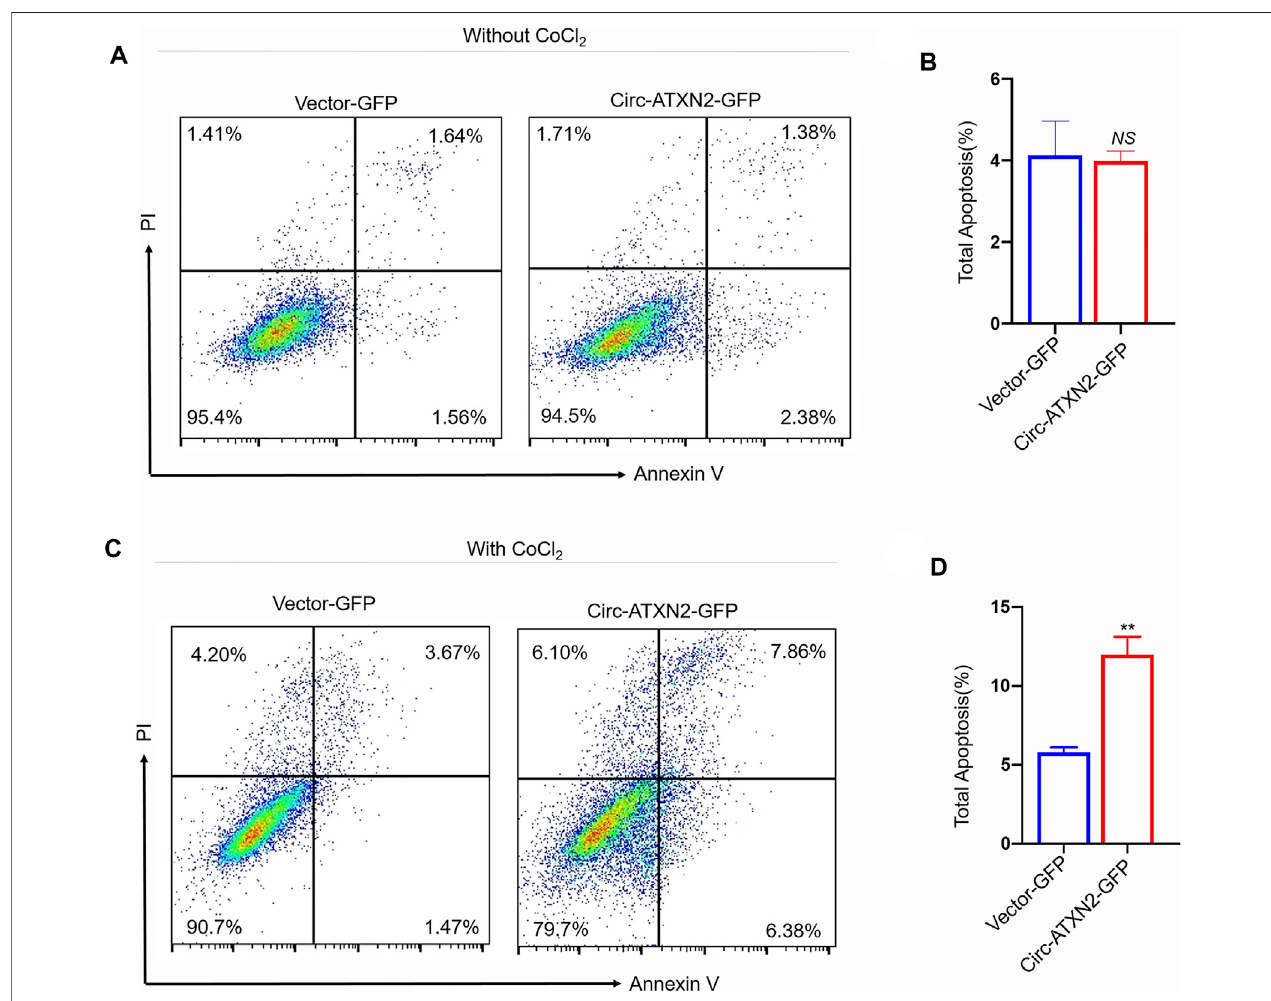
FIGURE 6 | Overexpression of circ-ATXN2 enhanced apoptosis in rat adipose-derived stem cells (ASCs). Cell apoptosis was determined by Annexin V-APC/PI counterstain followed by fl ow cytometry. (A) Apoptosis, detected using fl ow cytometry, showed the apoptotic cell rate in vector-GFP or circ-ATXN2-GFP-expressing cells. ASCs were without treated by CoCl 2 . (B) Data from experiments performed at least in triplicate are presented, showing the percentage of total apoptosis. (C) Apoptosis assay detected by fl ow cytometry showed the apoptotic cell rate in vector-GFP or circ-ATXN2-GFP cells. ASCs were treated by CoCl 2 (500 μ M, 24 h). (D) Data from experiments performed at least in triplicate are presented, showing the percentage of total apoptosis percentage. Results were presented as means ± SEM, by Student ’ s t test, n (cid:1) 3; ** p < 0.01, NS : no signi fi cance vs vector-GFP-expressing